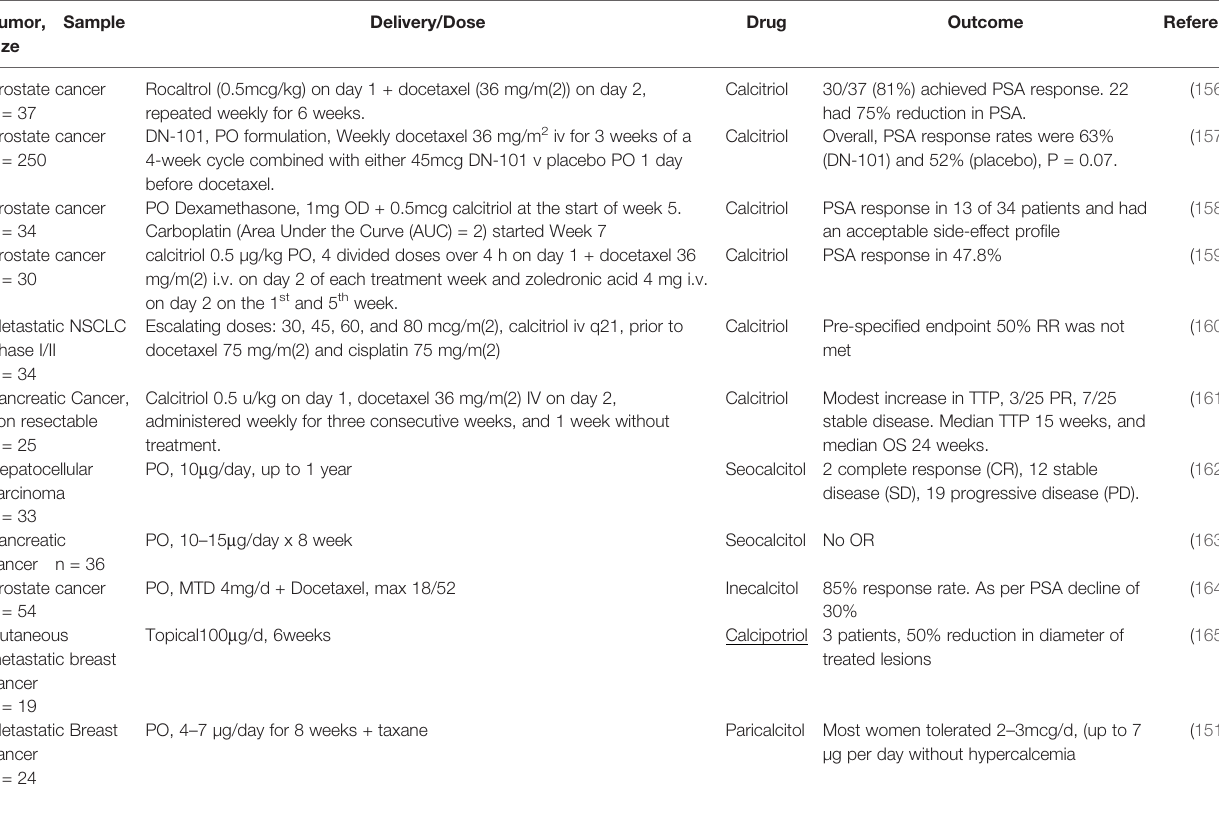
TABLE 4 | Completed Clinical trials of VDAs in various cancer types.